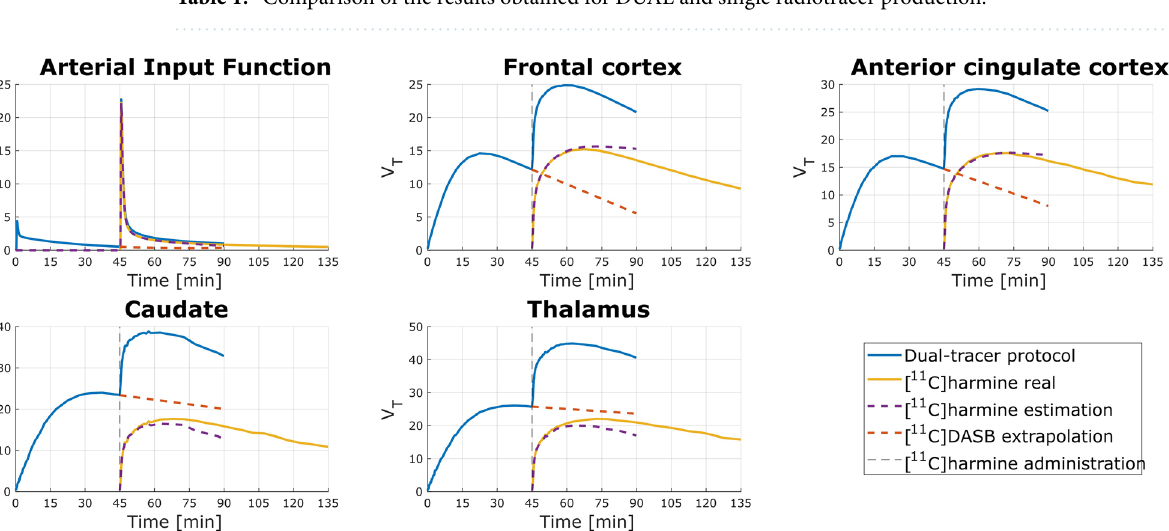
Table 1. Comparison of the results obtained for DUAL and single radiotracer production.